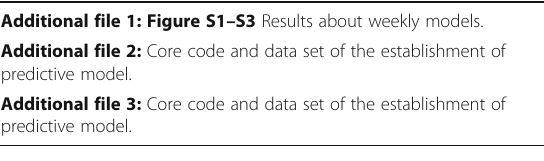
Additional file 1: Figure S1 – S3 Results about weekly models. Additional file 2: Core code and data set of the establishment of predictive model. Additional file 3: Core code and data set of the establishment of predictive